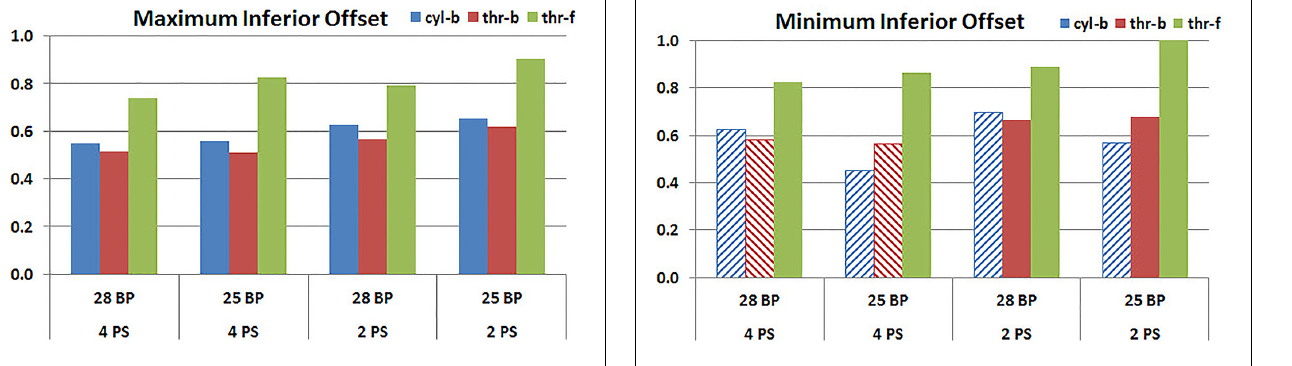
FIGURE 12 | Interfacial micromotion results using 28 and 25 mm baseplates (28 BP and 25 BP) and four and two peripheral screws (4PS and 2PS), with minimum inferior offset. The patterned bars represent the predictions where the primary trend (smaller baseplate resulted in increased micromotion) was